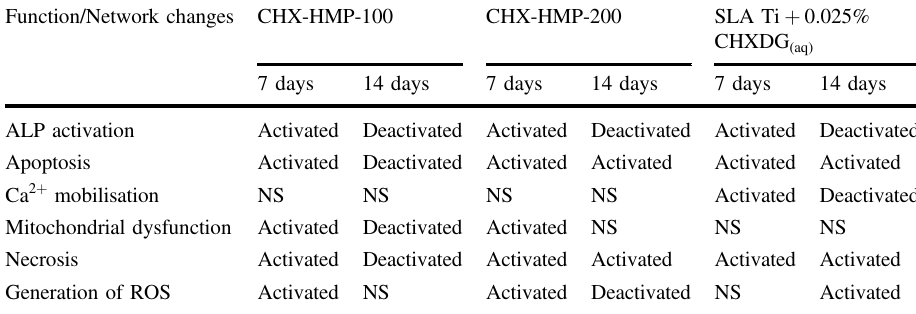
Table 4 Summary of signi fi cant changes to relevant hMSC functions on test surfaces at 7 and 14 days relative to SLA Ti